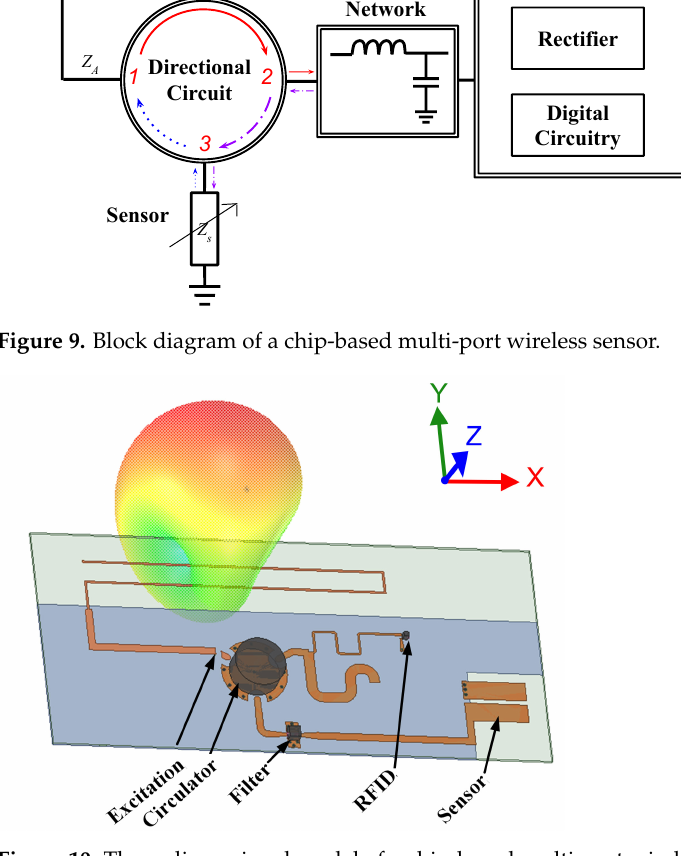
Figure 10. Three-dimensional model of a chip-based multi-port wireless sensor